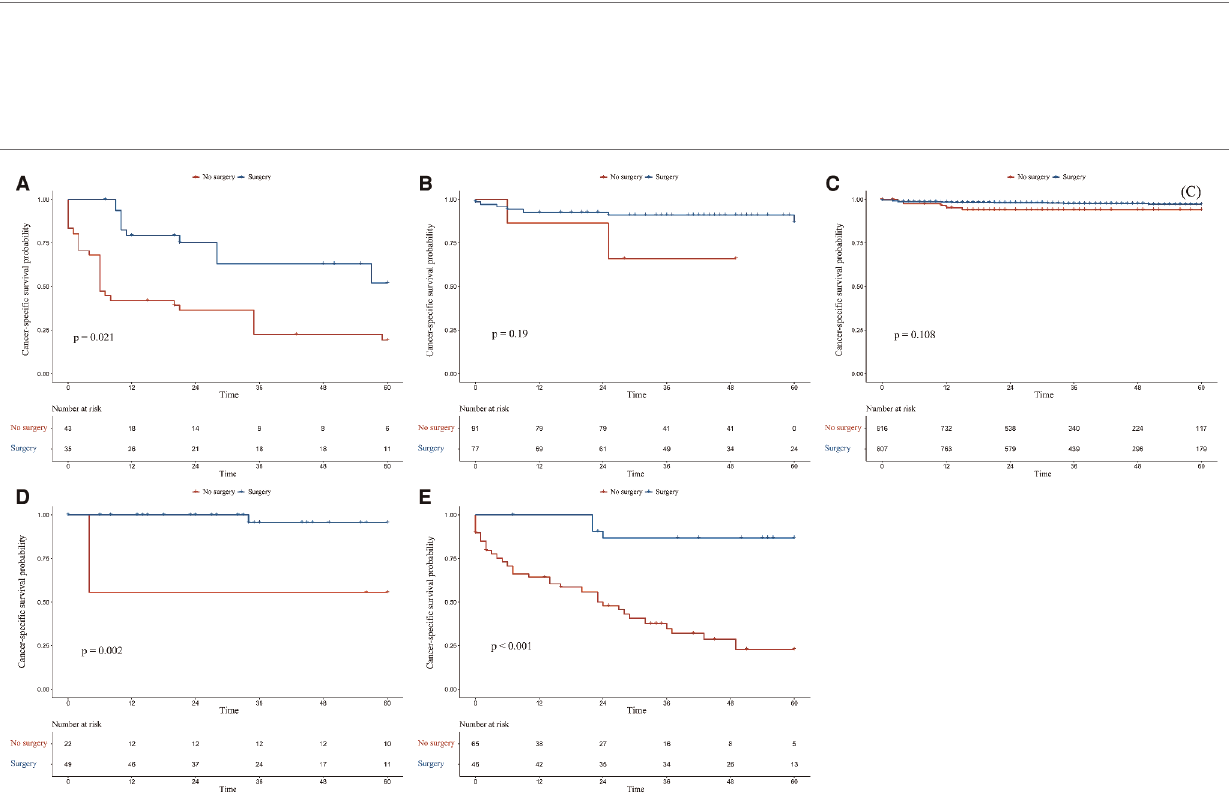
FIGURE 4 | Kaplan – Meier survival estimates of cancer-speci fi c survival in different subgroups after inverse probability of treatment weighting adjustment: ( A ) G1, ( B ) M0N1G0, ( C ) M0N0G0, ( D ) M0N0G0E1, and ( E )